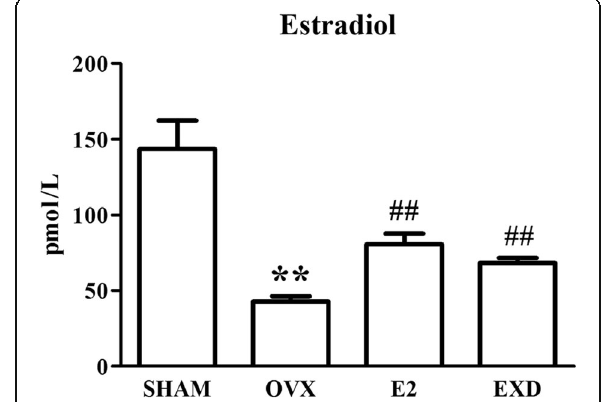
Fig. 3 Effect of EXD on level of estradiol 2 in serum after 12-week treatment. ** P <0.01 versus SHAM group; ## P <0.01 versus OVX